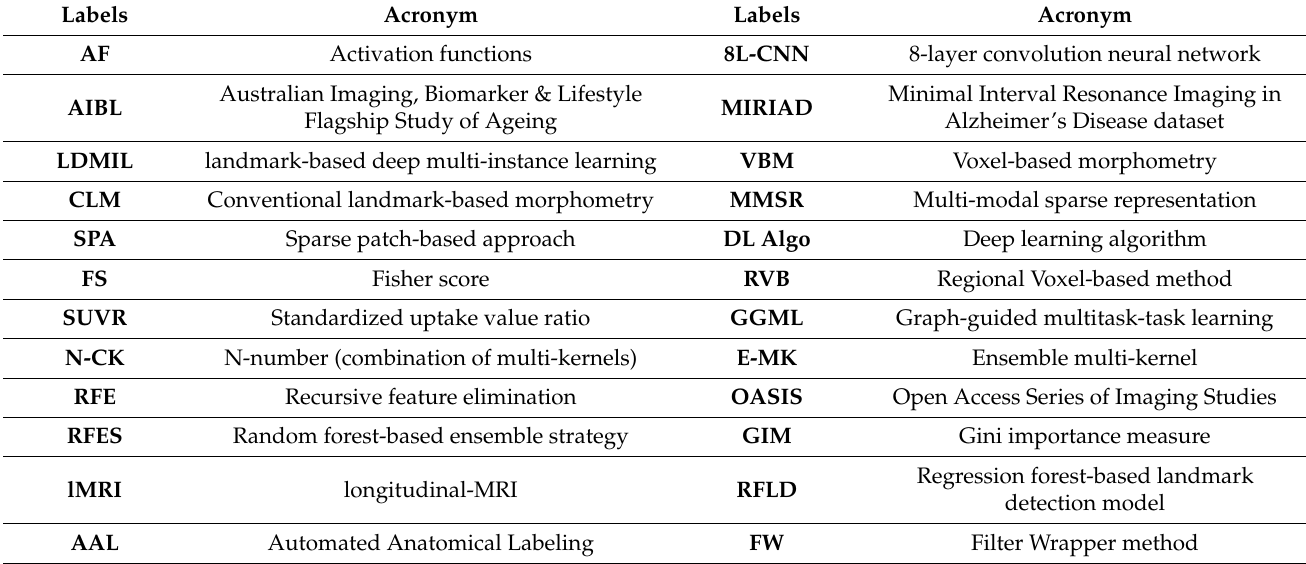
Table A1. Acronym for labels used in Table